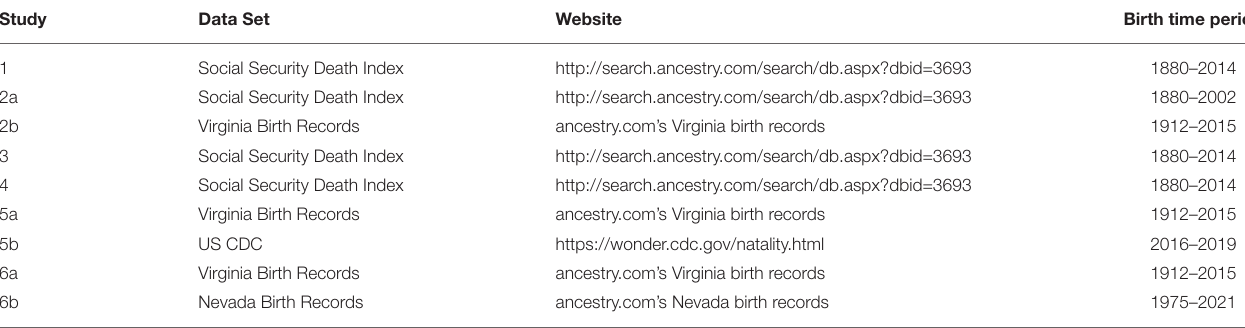
TABLE 1 | Summary of the data sets, websites, and time periods used in this report. Study